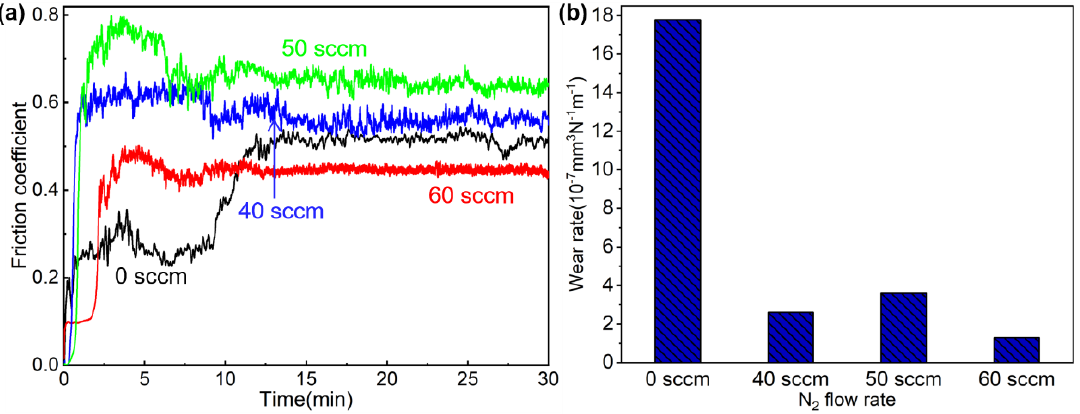
Figure 13. Tribological properties of different TiAlN samples: ( a ) friction coefficients, ( b ) wear